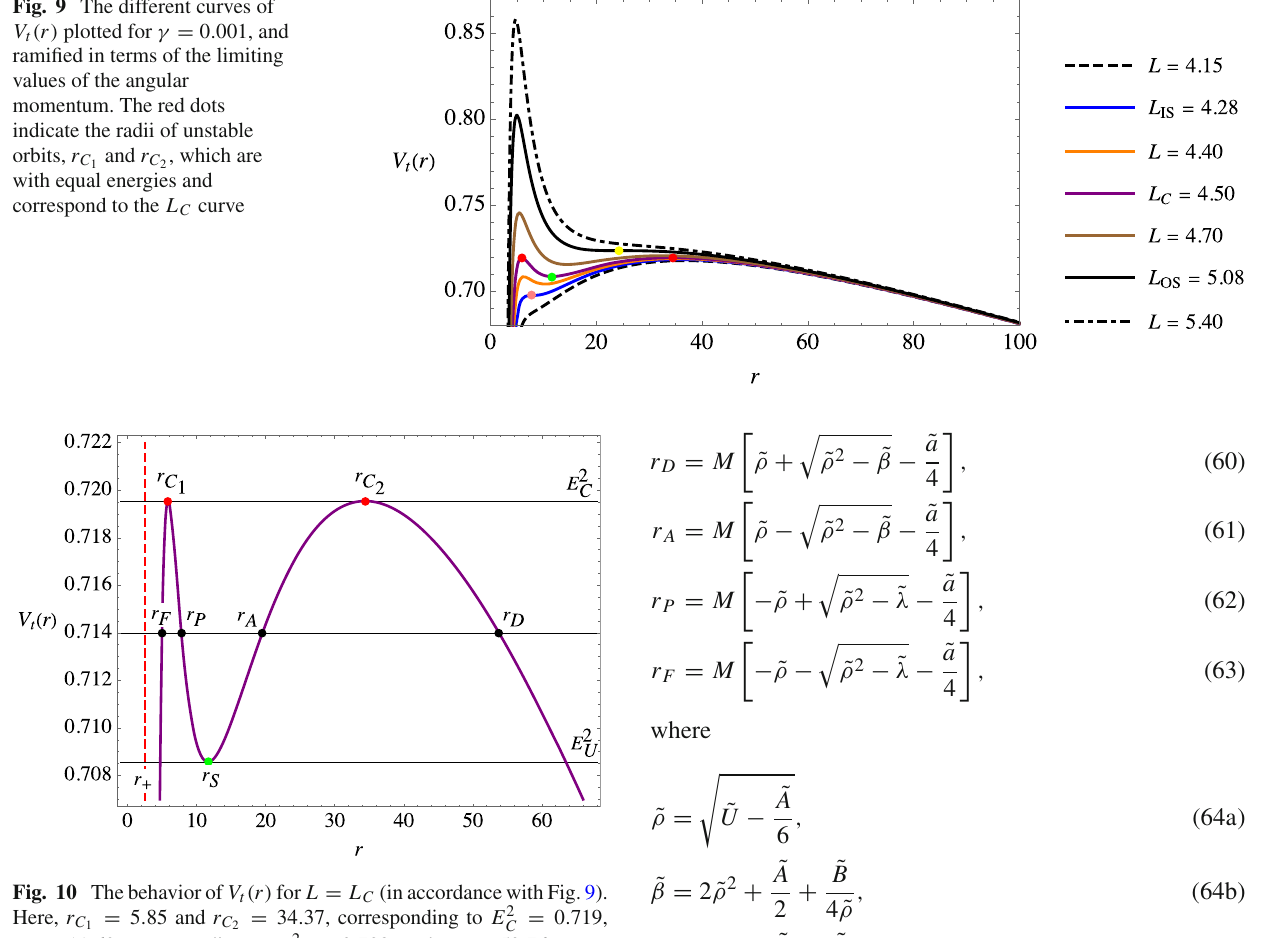
Fig. 10 The behavior of V t ( r ) for L = L C (in accordance with Fig. 9). = 5 . 85 and r = 34 . 37, corresponding to E 2 = 0 . 719, Here, r C C 2 C 1 = 0 . 708, and r = 53 . 76, r = r S = 11 . 63 corresponding to E 2 D A U 19 . 51, r P = 7 . 77 and r F = 4 . 96, corresponding to E 2 = 0 .